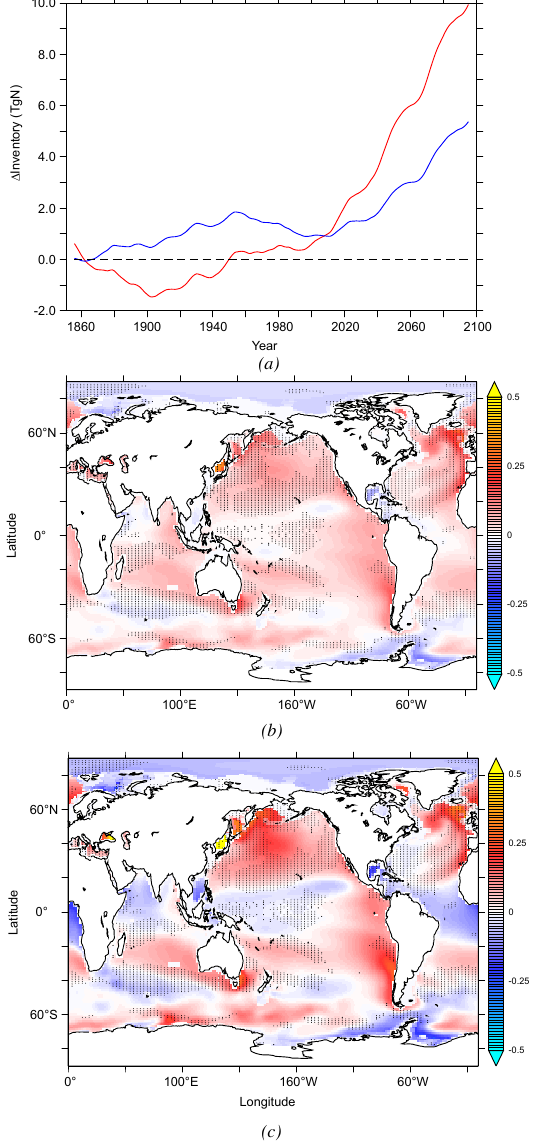
Figure 6. (a) Anomalies in N 2 O inventory (in TgN) from 1851 to 2100 in P.TEMP (blue) and P.OMZ (red) using the historical and fu- ture RCP8.5 simulations in the upper 1500m. Change in vertically integrated N 2 O concentration (in mgNm − 2 ) in the upper 1500m using NEMO-PISCES model mean from the averaged 2080–2100 to 1985–2005 time periods in future RCP8.5 and historical scenar- ios, respectively, in (b) P.TEMP and (c) P.OMZ. Hatched areas in- dicate regions where the annual mean mixed layer depth is reduced by more than 5m in 2080–2100 compared to 1985–2005.